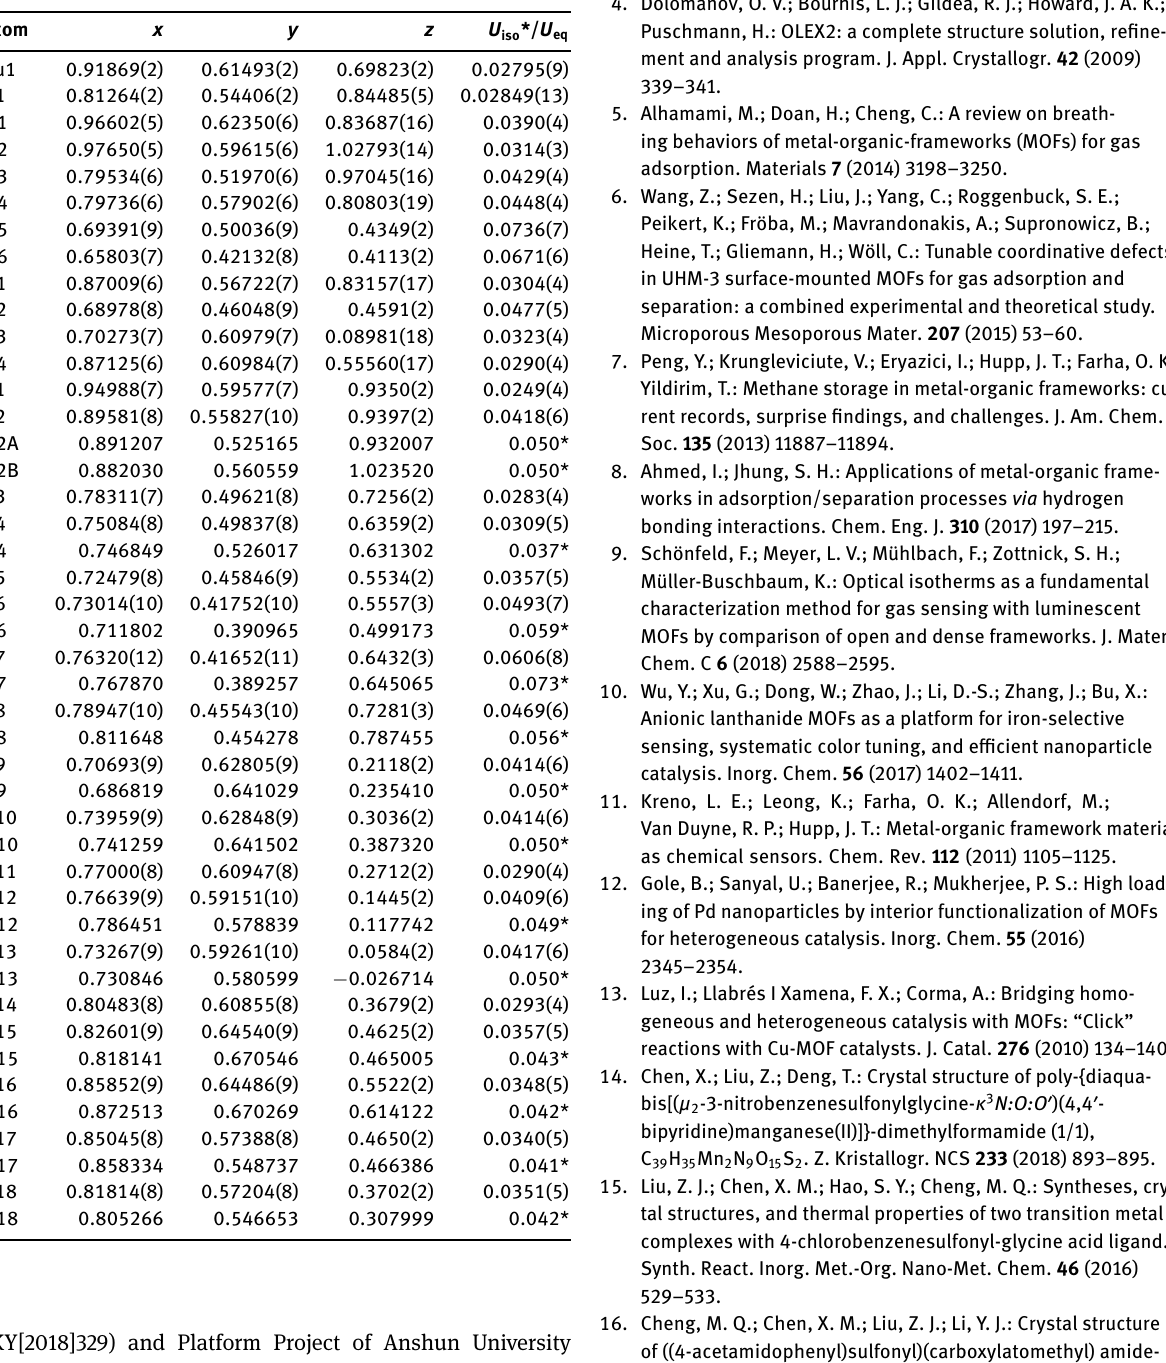
Table 2: Fractional atomic coordinates and isotropic or equivalent isotropic displacement parameters (Å 2